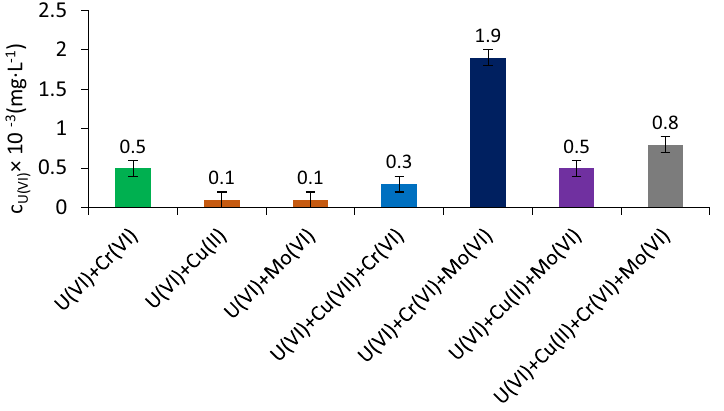
Figure 10. Influence of accompanying metallic ionic species C i = 10 mg·L −1 on the variation of U(VI) content in the aqueous diluted systems after sorption / precipitate